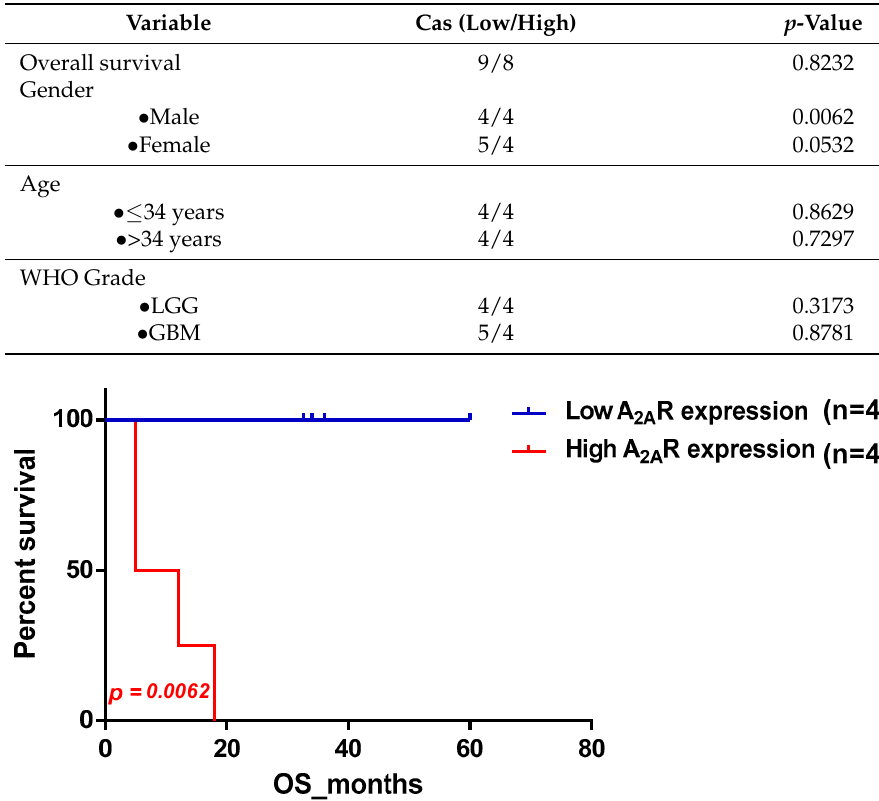
Figure 1. Survival curve according to A 2A R expression, indicating poor survival in Moroccan males. Patients were divided into two groups based on median A 2A R expression. Blue curve represents patients with low expression and red represents high A 2A R expression.